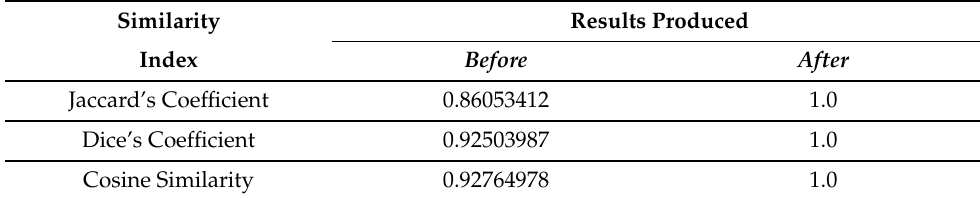
Table 2. Similarity Measure for random injection.